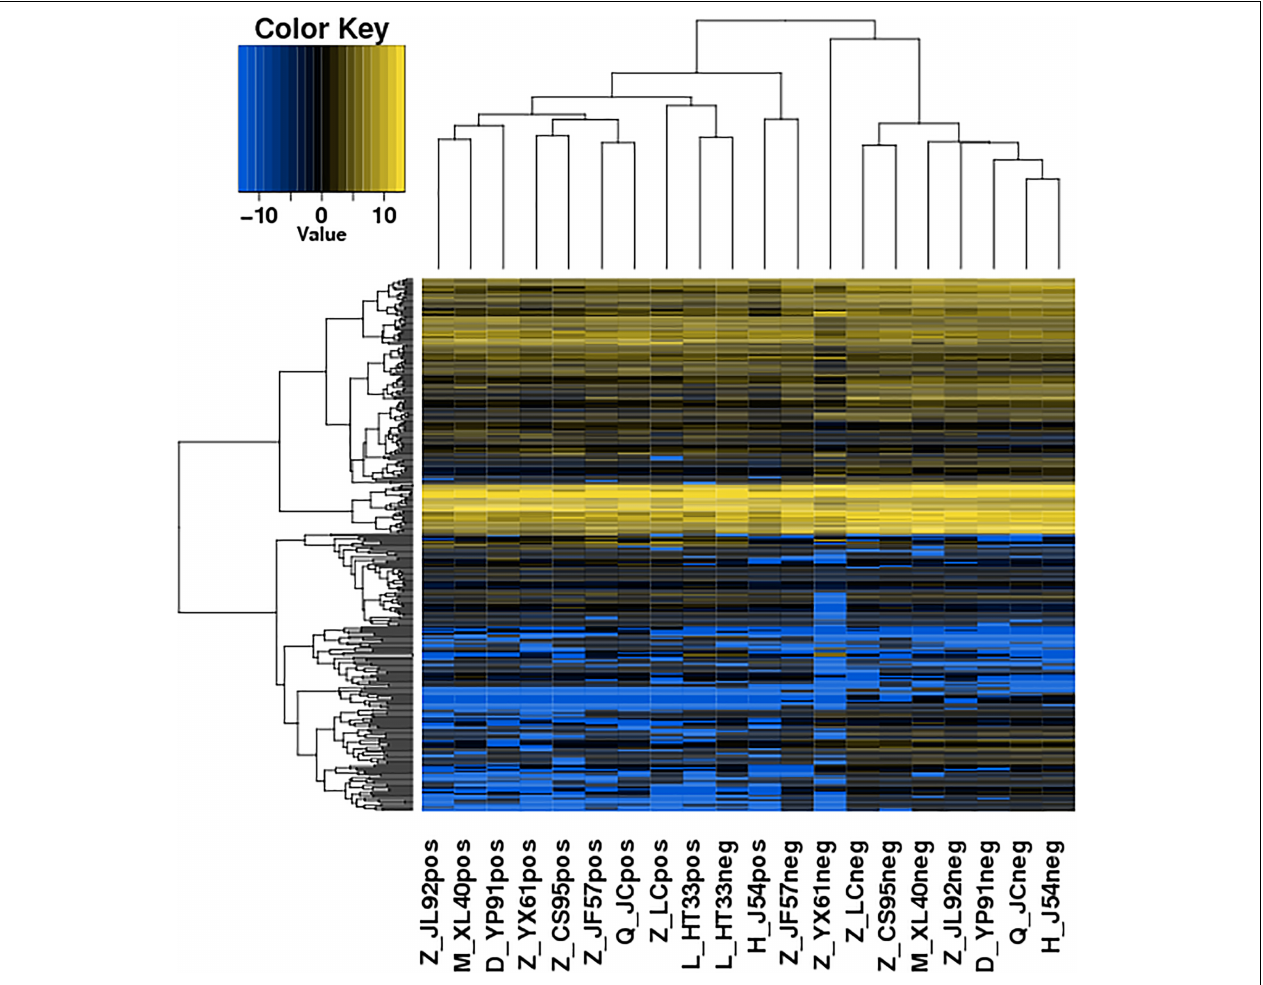
FIGURE 5 | Heatmaps of DE microRNA: According to the expression level of differentially expressed microRNA in each sample, the clustering results of the sample were obtained. In the figure, the various colors represent different expression levels. Blue color indicates the lower expression level, and yellow color indicates the higher expression